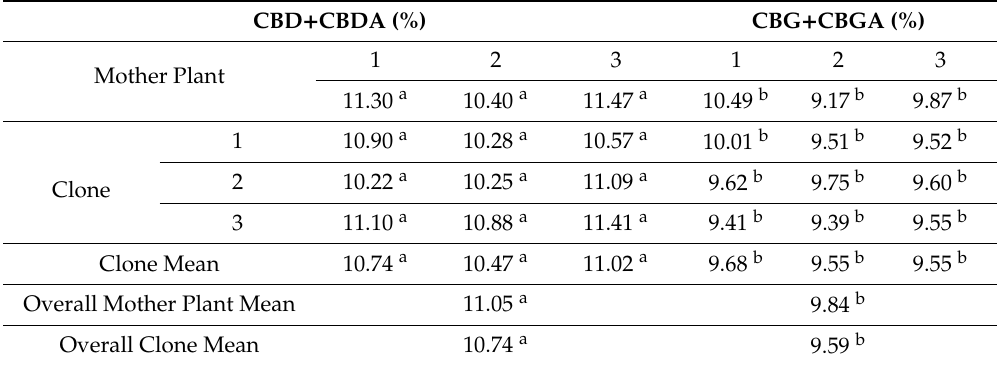
Table 3. Analysis of variance of the CBD + CBDA and CBG + CBGA content (%) of the three field grown mother plants and their clones of the two high CBD and CBG Cannabis sativa . (Means followed by the same letter do not di ff er statistically at p = 0.05 according to Duncan test.). CBD + CBDA (%) CBG + CBGA (%) 1 Mother Plant